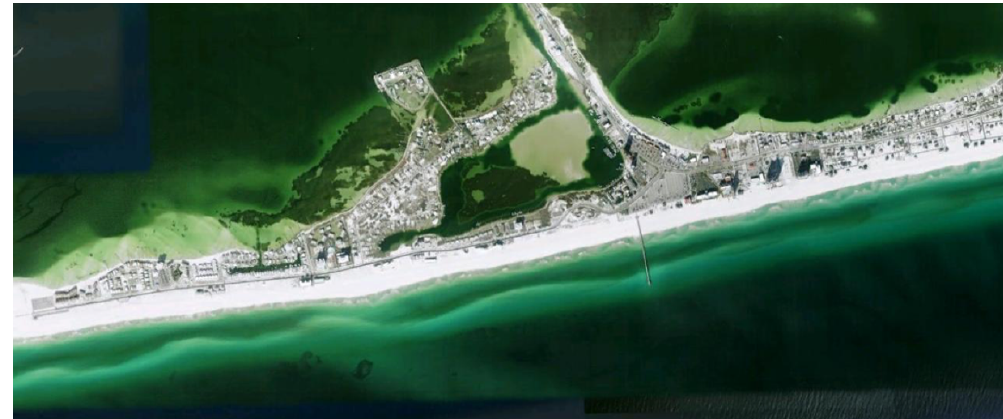
Figure 2. Satellite image of the flagged section of beach in April 2004 (before Hurricane Ivan) showing the presence of transverse-bar and rip morphology of the innermost bar and the variable nature of the outermost bar for the flagged section of beach. The aerial image is not necessarily representative of the nearshore morphology throughout the remainder of the study (© Google Earth 2019).